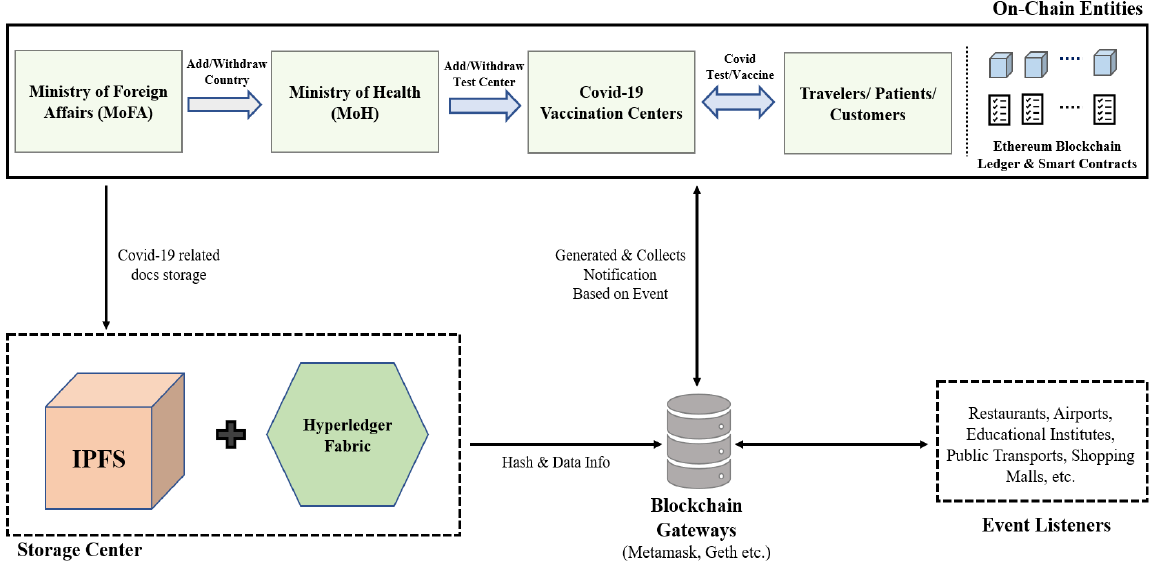
Figure 3. Proposed blockchain architecture for digital health passports with vaccination certificates.